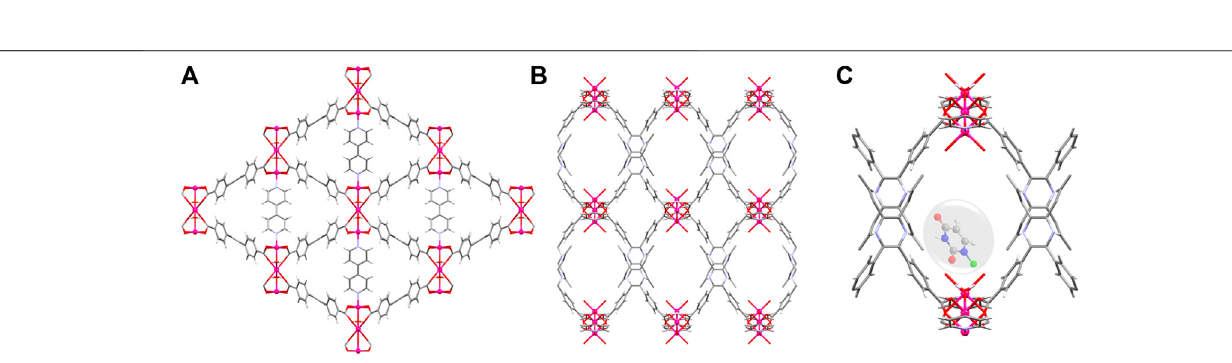
Frontiers in Materials |